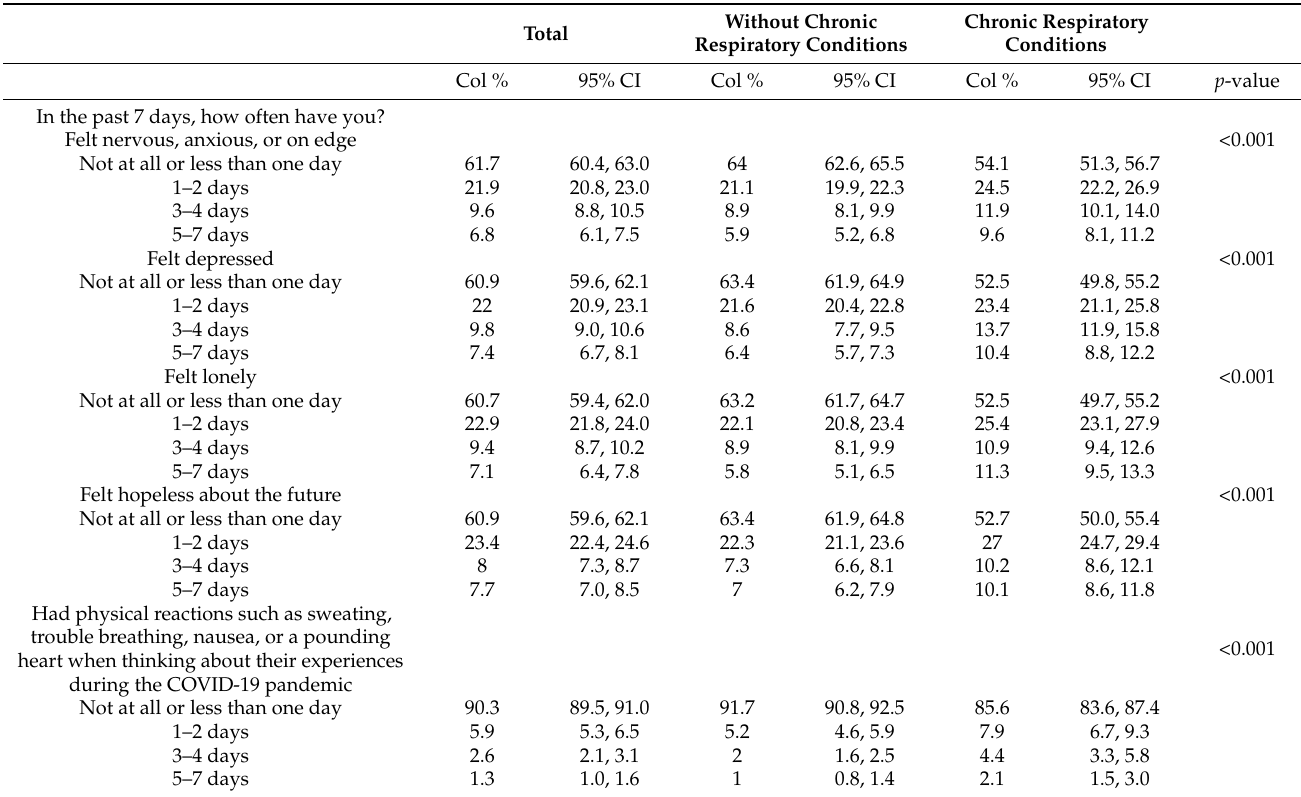
Figure 1 summarizes the prevalence ratios of physical symptoms by